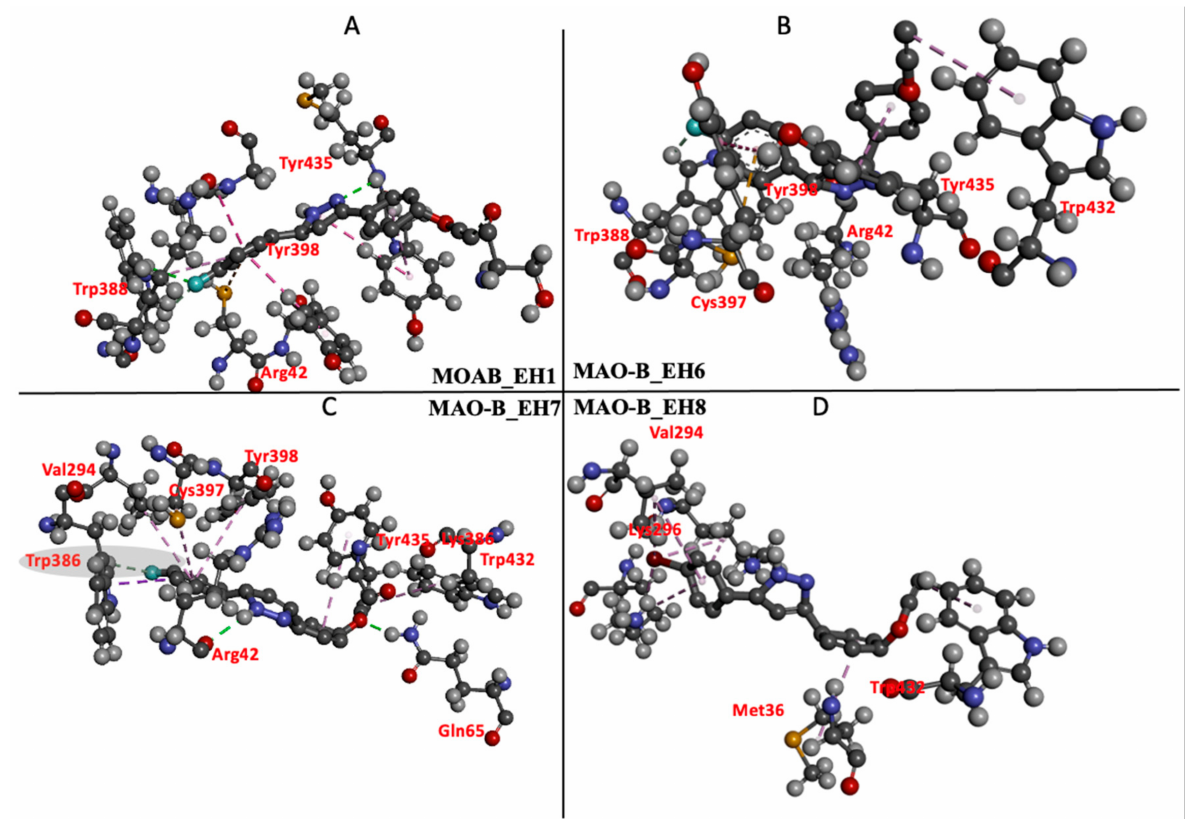
Figure 9. Ligand interaction profile of the interaction of EH1 ( A ), EH6 ( B ), EH7 ( C ), and EH8 ( D ) with